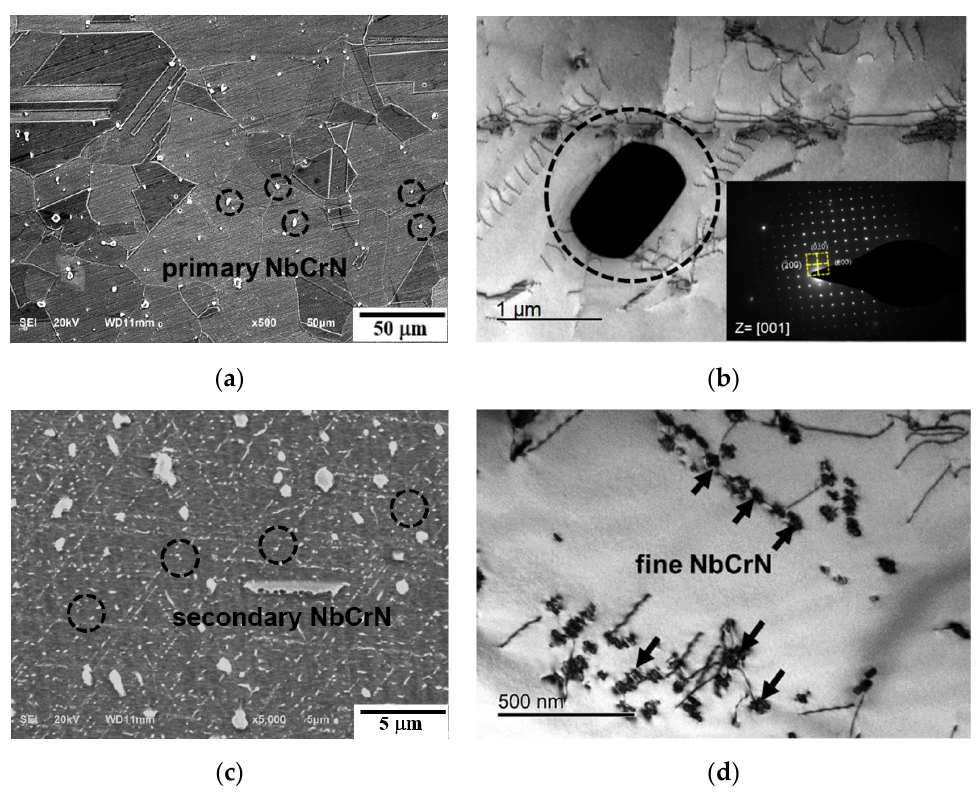
Figure 5. SEM and TEM micrographs of Z-phase in the specimen of: ( a , b ) as-received, ( c , d ) 700 °C/90 MPa/9411 h.